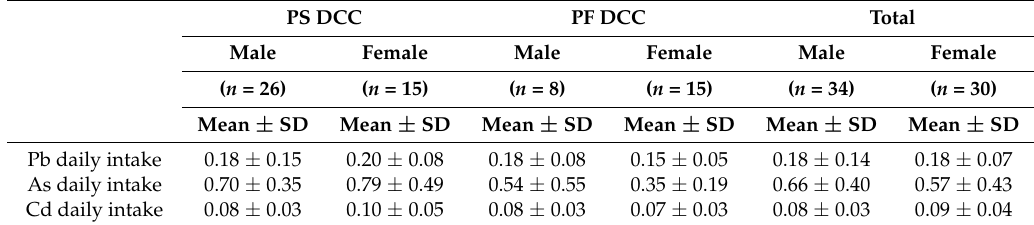
Table 4. Children’s total daily intake of lead (Pb), arsenic (As), and cadmium (Cd) ( µ g kg − 1 bw − 1 day) from two day care centers of S ã o Paulo (PS DCC and PF DCC),